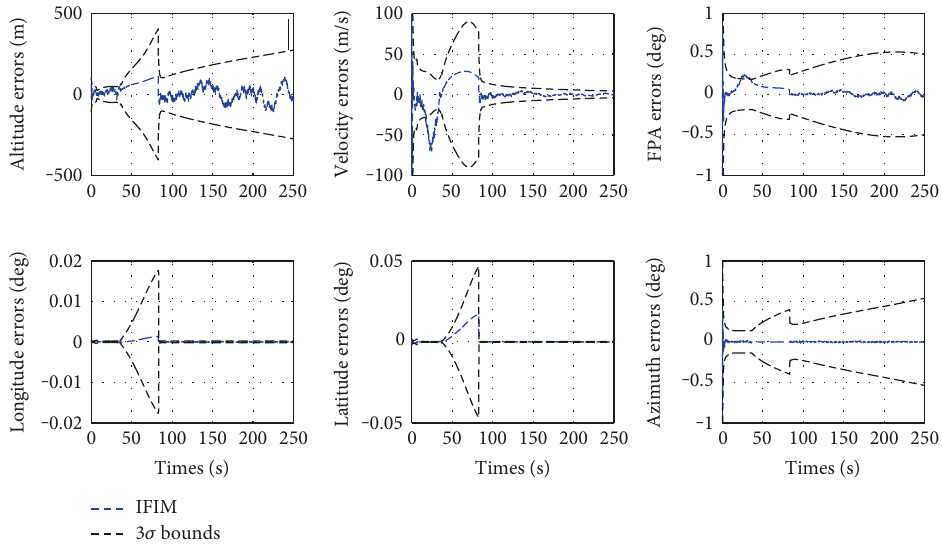
Figure 8: State estimate errors and 3 σ bounds of IFIM for IMU/orbiter integrated navigation scenario.